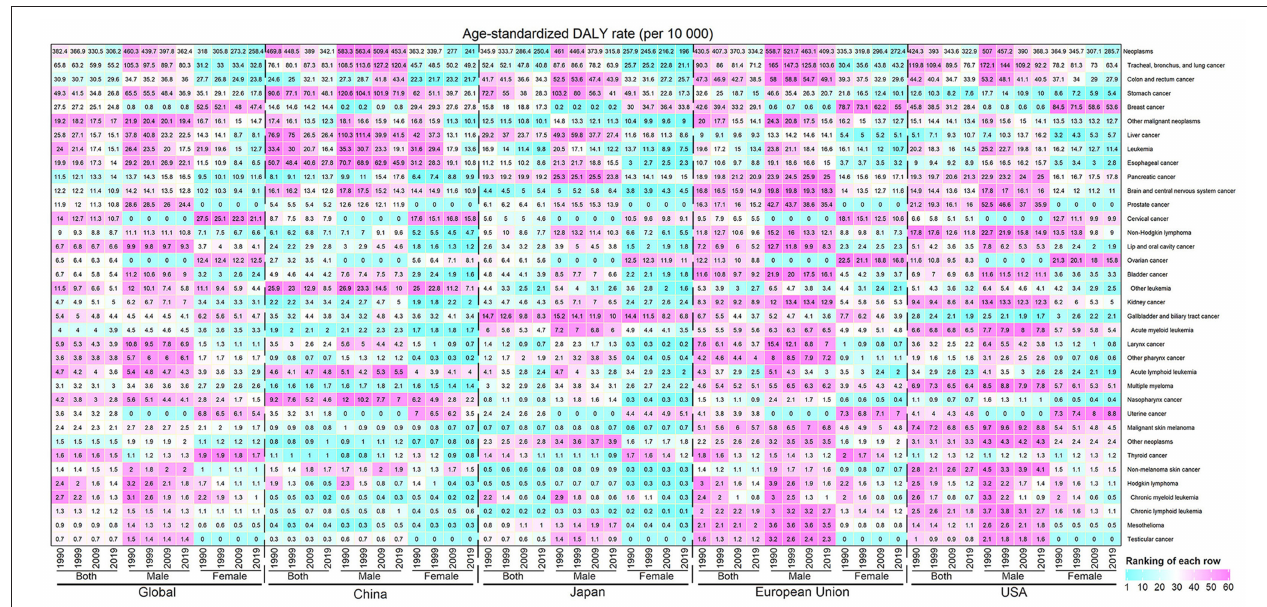
FIGURE 2 | The ASDR distribution of 36 neoplasm types in the world, China, Japan, European Union, and USA were stratified by gender in 1990, 1999, 2009, and 2019. The color represents the ranking of each row (cyan is low and magenta is high).